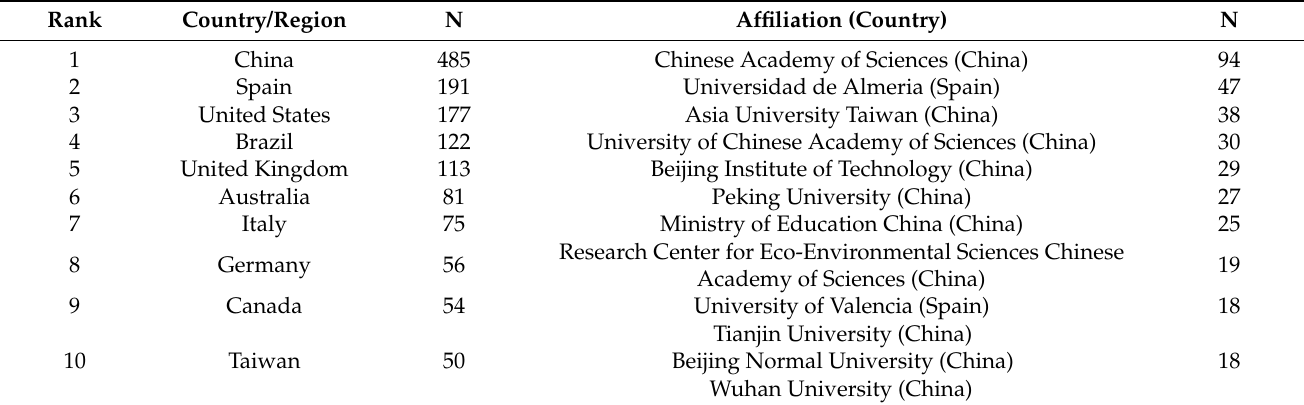
Table 14. Top 10 countries and affiliations publishing in Environmental Sciences category. Rank